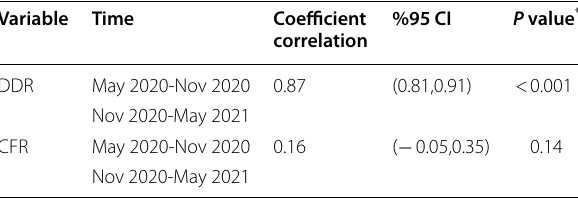
* :Spearman rank correlation coefficient